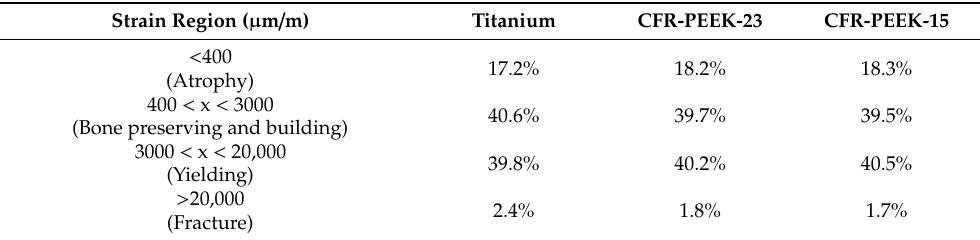
Table 4. Comparison of the percentage of analyzed nodes, categorized into the di ff erent strain regions after shell relaxation and dependent on the shell material (Titanium, CFR-PEEK-23 or